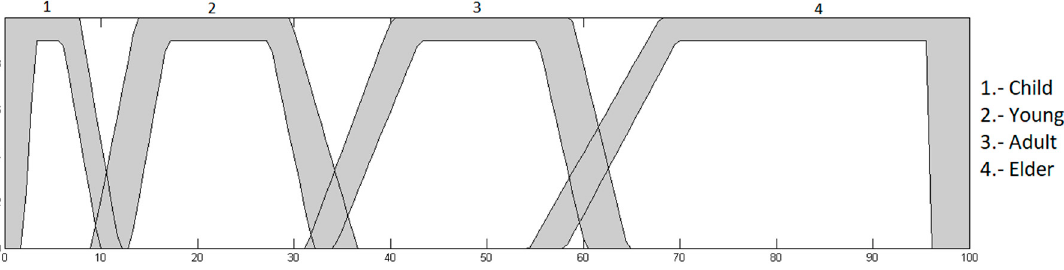
Figure 12. Age input with trapezoidal MFs.